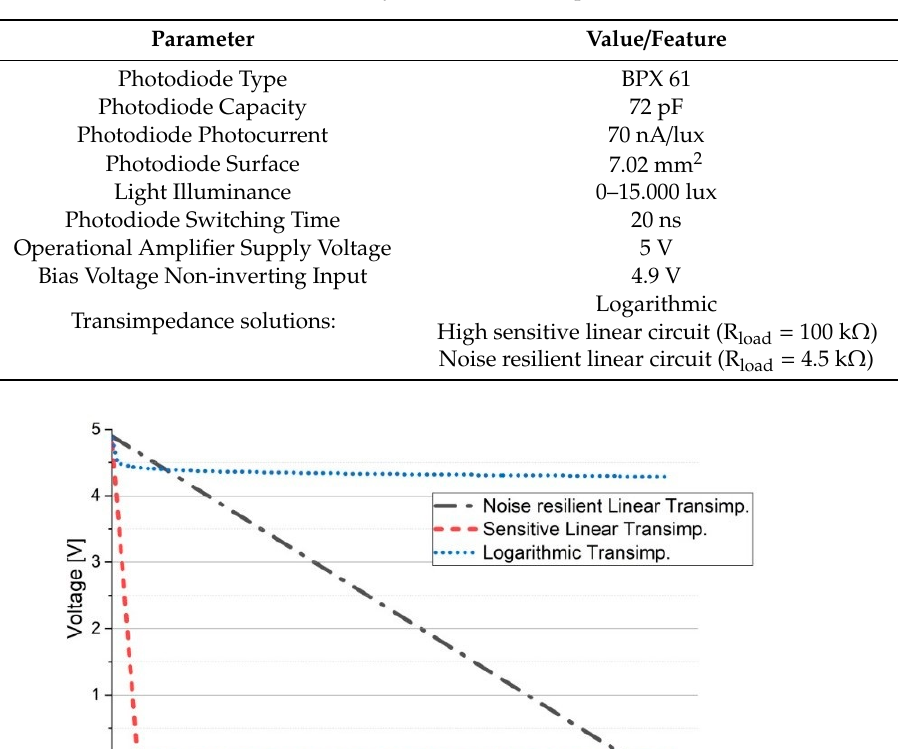
( b) Figure 5. ( a ) LED traffic light spectral analysis; ( b ) Sunlight spectral analysis during the tests.